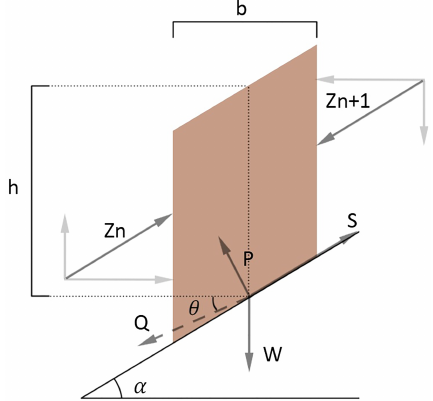
Figure 1. Representation of the forces acting on a slice, consid- ered in Spencer’s method (Spencer, 1967). W is the external vertical loads; Zn and Zn + 1 are the forces acting on the left- and right-hand side of each slice, respectively, with their horizontal and vertical components. P and S are the normal and tangential forces at the base of the slice; α is the angle of the slope referred to each slice, b is the slice width and h is the mean height of slice (if the height is not